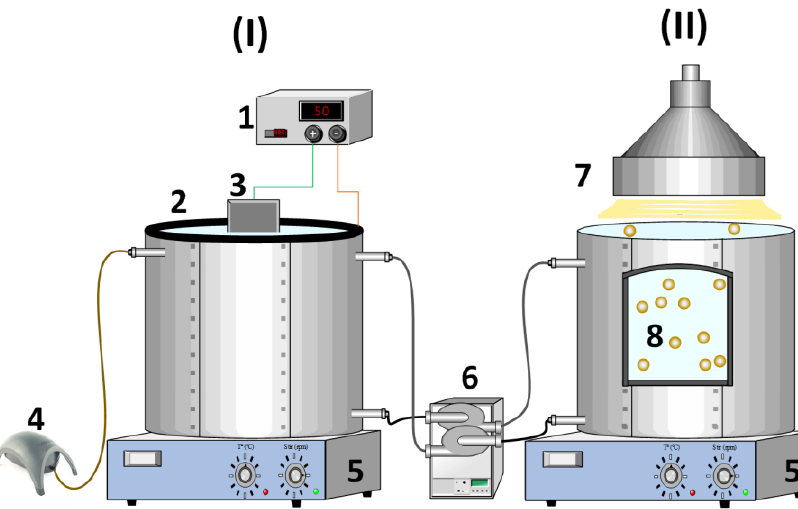
Figure 8. Cyclic electro-photocatalytic reactors: ( I ) electrochemical reactor: ( 1 ) power supply, ( 2 ) carbon felt electrode, ( 3 ) BDD electrode, ( 4 ) air supply, ( 5 ) magnetic stirrer, ( 6 ) peristaltic pump; ( II ) photocatalytic reactor: ( 5 ) magnetic stirrer, ( 7 ) UV-LED lamp, ( 8 ) catalytic